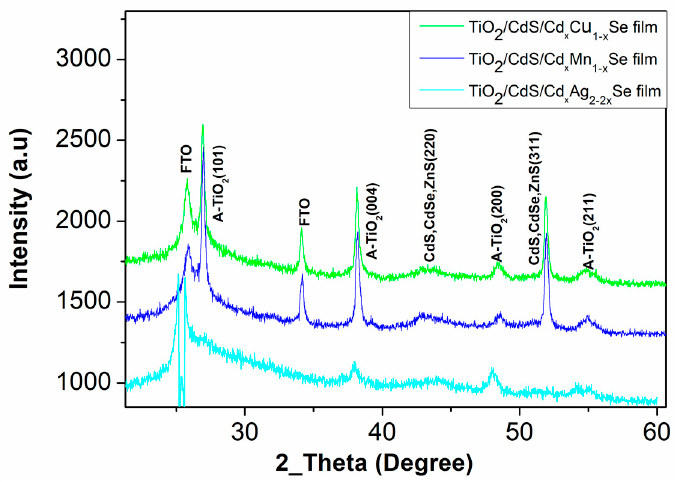
Figure 1. The X-ray diffraction of the TiO 2 /CdS/Cd x Cu 1 − x Se, and TiO 2 /CdS/Cd x Mn 1 − x Se and TiO 2 /CdS/Cd x Ag 2 − 2x Se